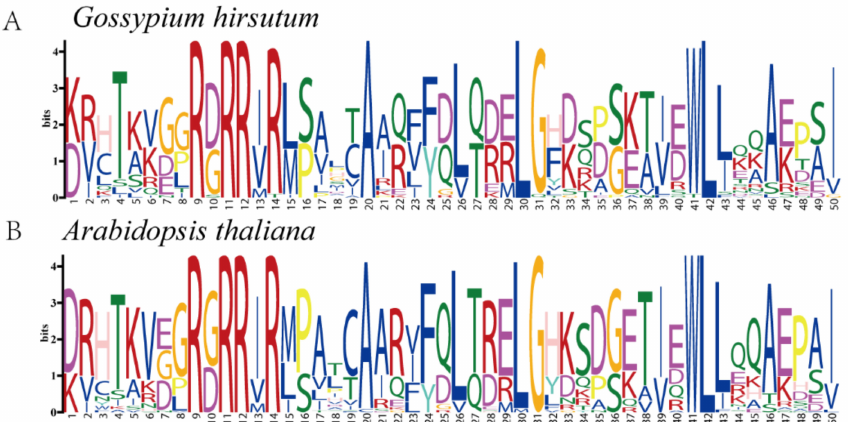
Figure 3. Sequence logos for conserved amino acid residues in ( A ) G. hirsutum and ( B ) Arabidopsis